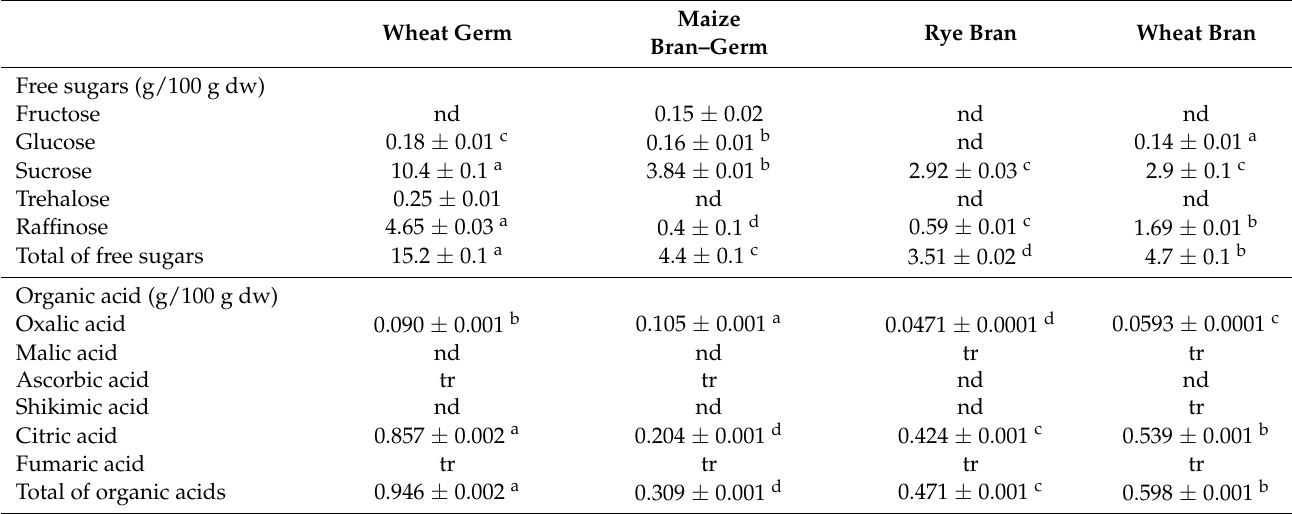
Table 2. Composition in sugars and organic acids of the cereal by-products. Wheat Germ